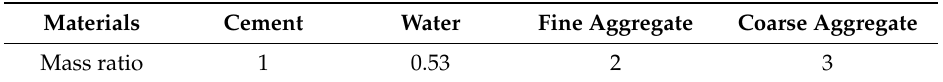
Table 4. Parameters of the specimens. Table 2. The mineral composition of P · I 52.5 Portland cement (mass